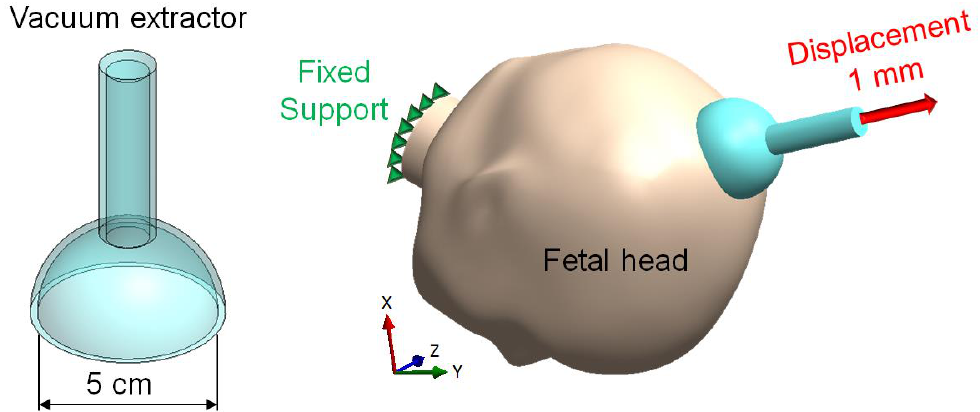
Figure 1. The vacuum extractor plotted herein and the finite element analysis model of using a vacuum extractor on the fetal head.